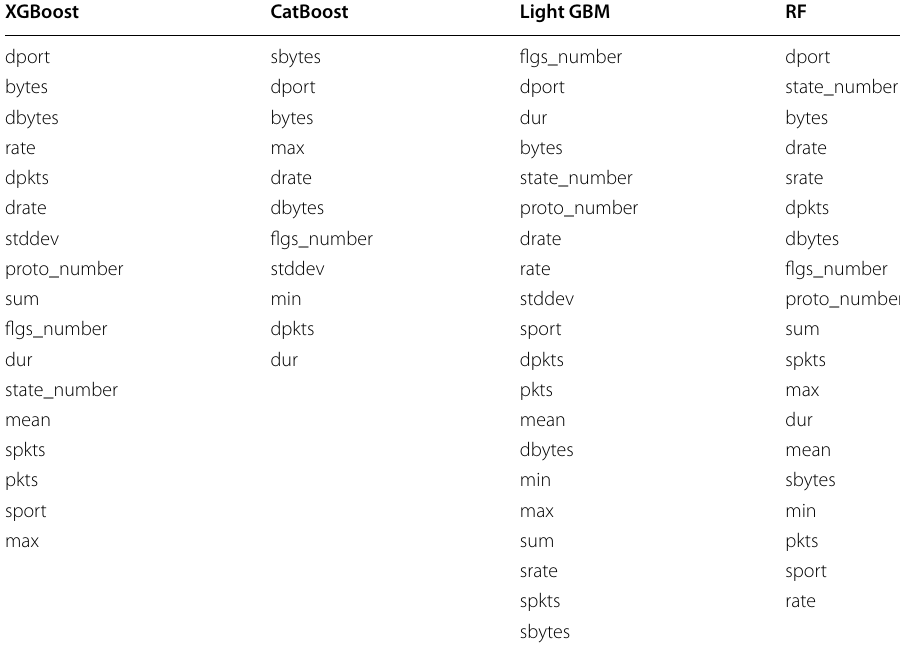
Table 51 Features by supervised ranking feature importance